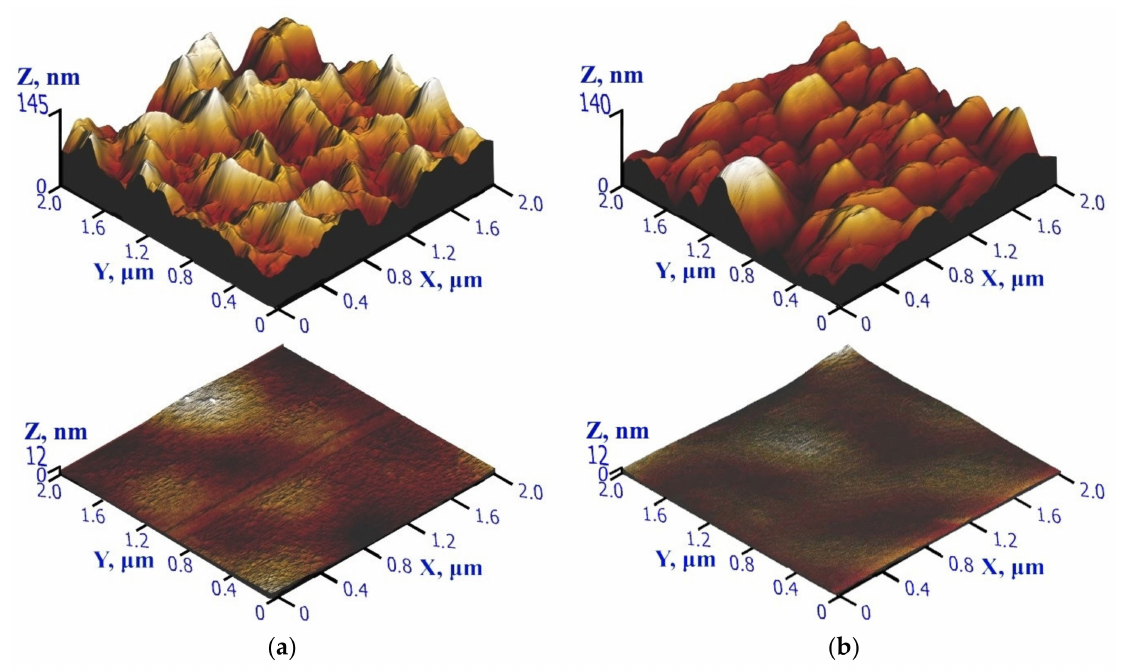
Figure 3. AFM images of AlN surfaces before ( top ) and after ( bottom ) Ar cluster ion beam on Sitall (glass-ceramics) ( a ) and Si ( b )